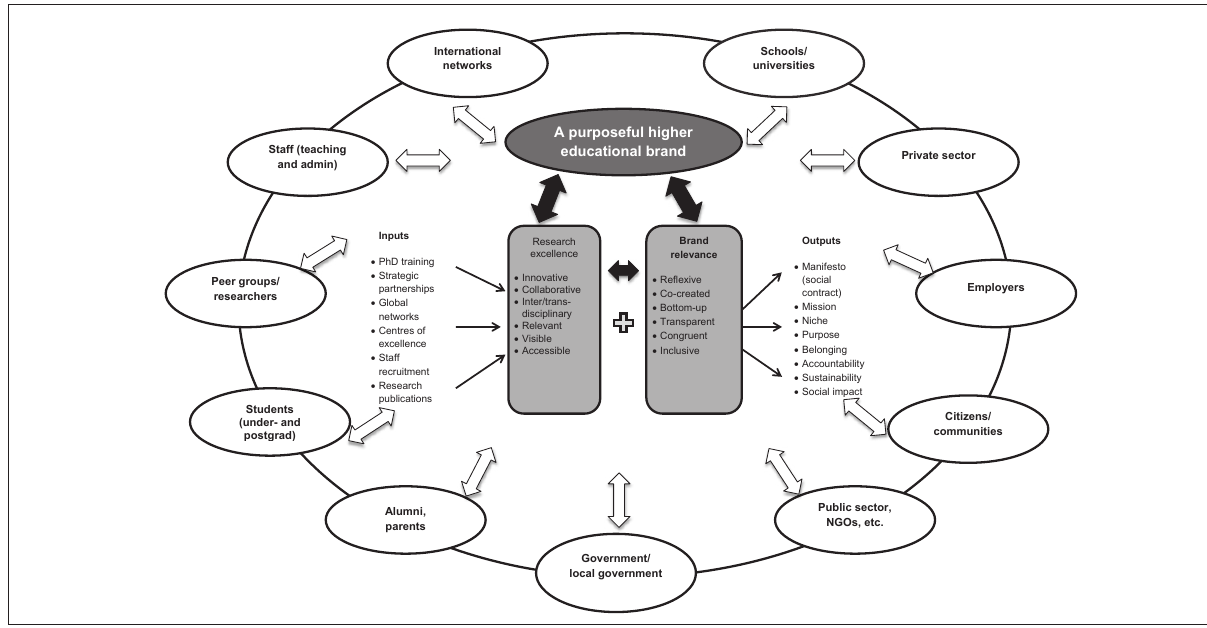
Figure 1: An alternative model for strategic higher education reputation building.